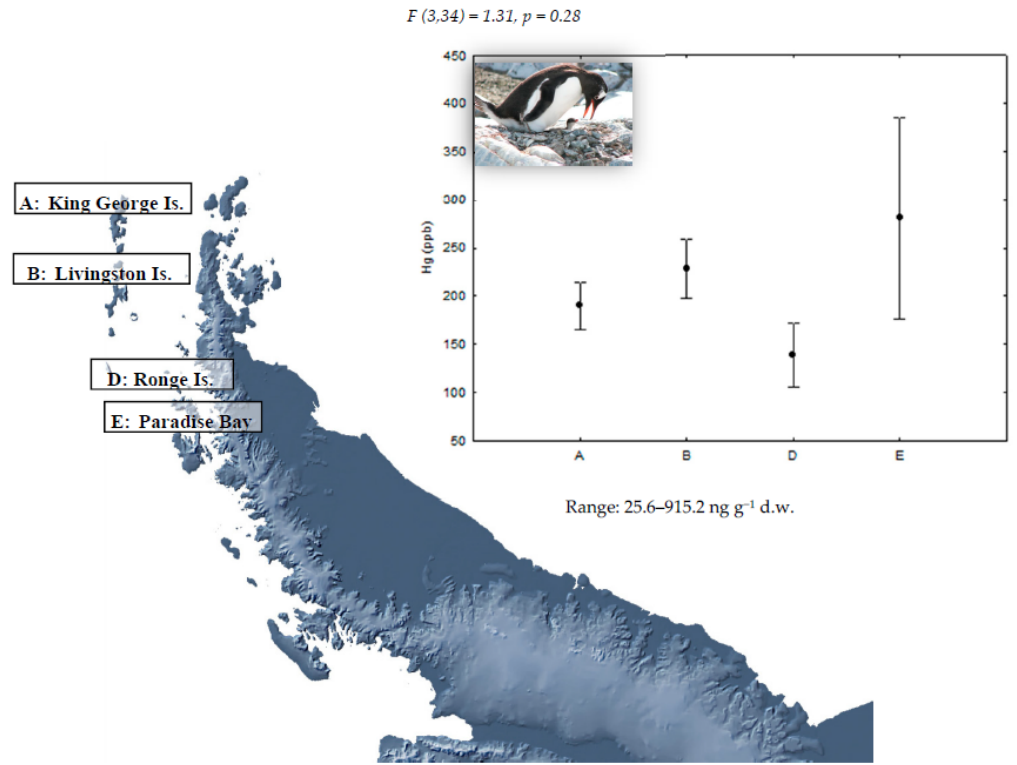
Figure 1. Mean ( ± SE) Hg concentration in feathers of gentoo penguins ( P. papua ) in four locations of the Antarctic Peninsula area. For sample sizes, see Table 1.